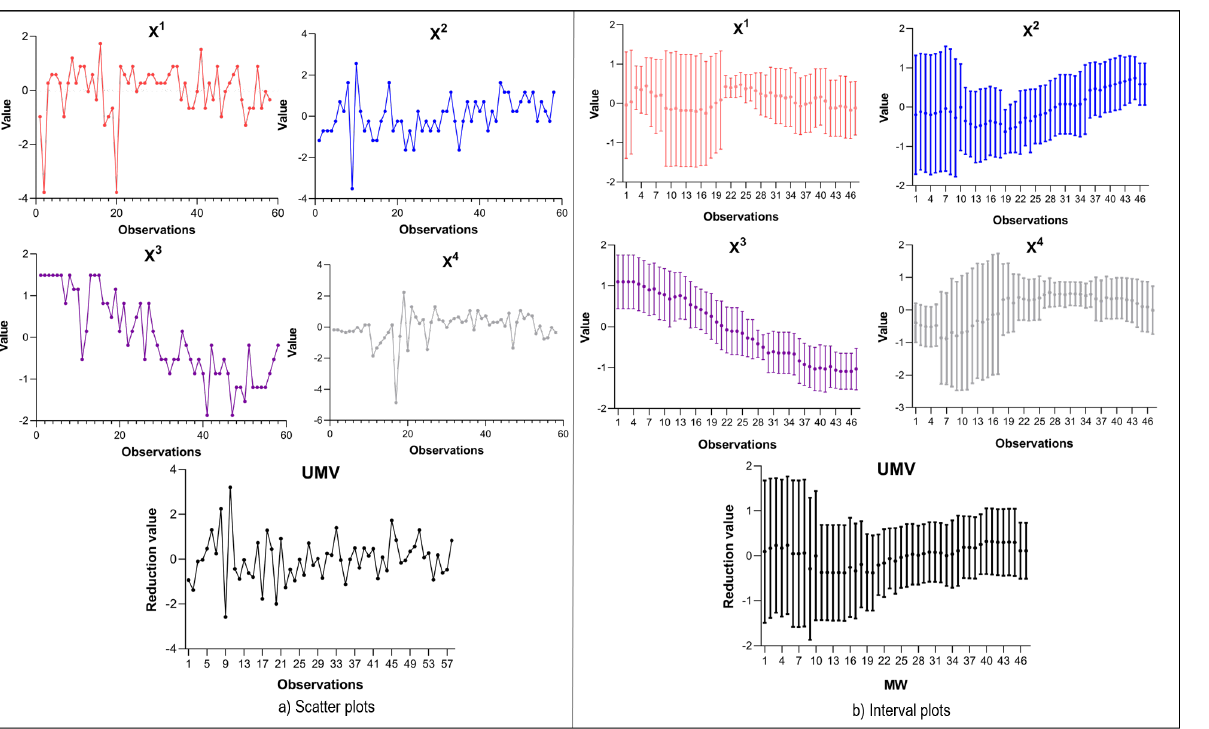
Figure 4. X Graph considering ( a ) scatter plots and ( b ) intervals. A Unified Multivariate Variable ( UMV ) vector of dimension n can be seen as a representation of the values of a variable in n elements of a population, which can be seen in the graph as